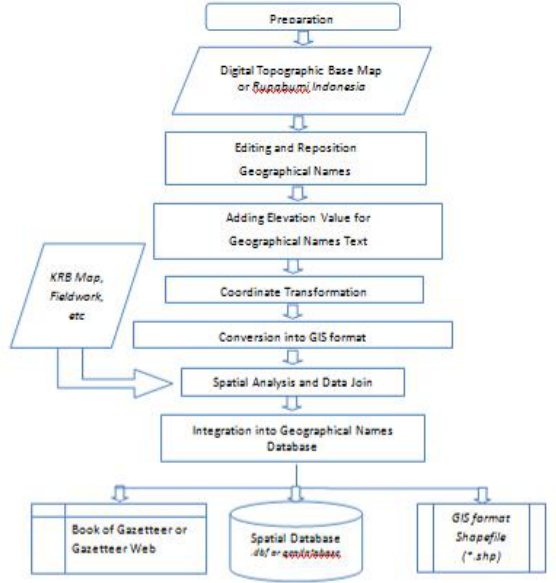
Figure 8. The step of building geographical names database (Source: Modified from KAKT, Pusat Pemetaan Dasar